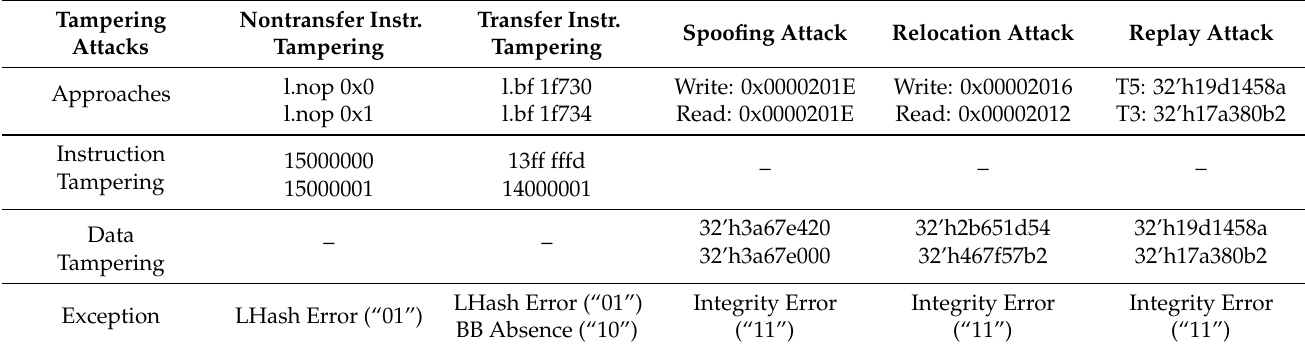
Table 3. Security capability tests of SoC with integrating SMU under different tampering